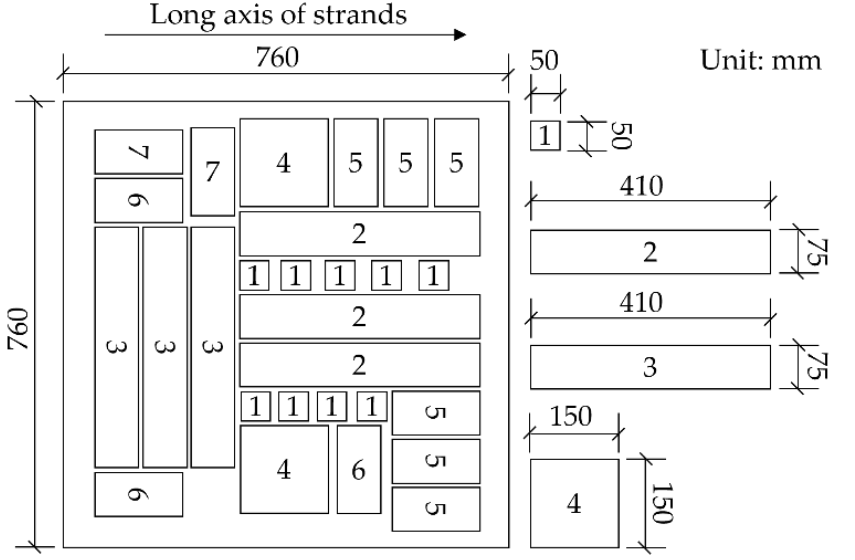
Figure 1. Cutting scheme of the specimens from the produced OSB: (1) vertical density profile and internal bond strength; (2) parallel bending modulus of elasticity and modulus of rupture; (3) perpendicular bending modulus of elasticity and modulus of rupture; (4) thickness swelling.